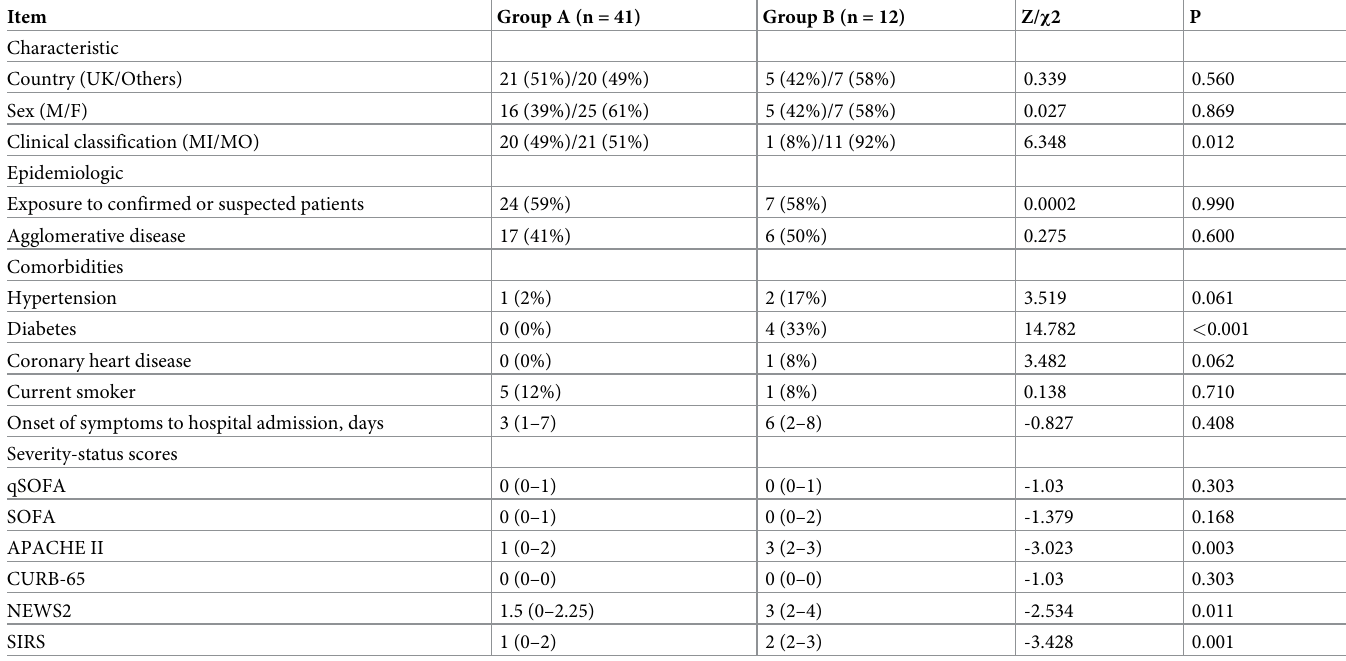
Table 1. General data of the two